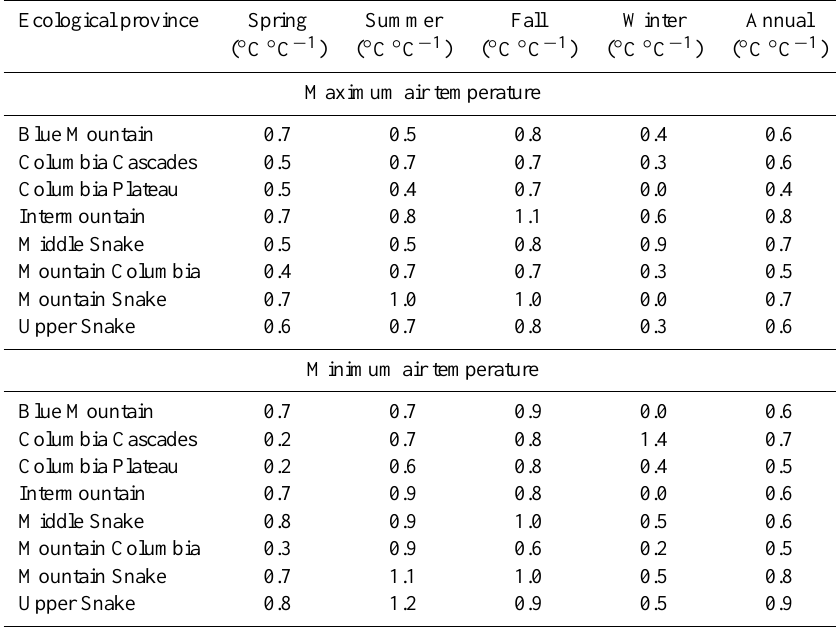
Table 4. Sensitivities of stream temperature changes to changes in maximum and minimum air temperatures for the Columbia River basin during the 2080s.